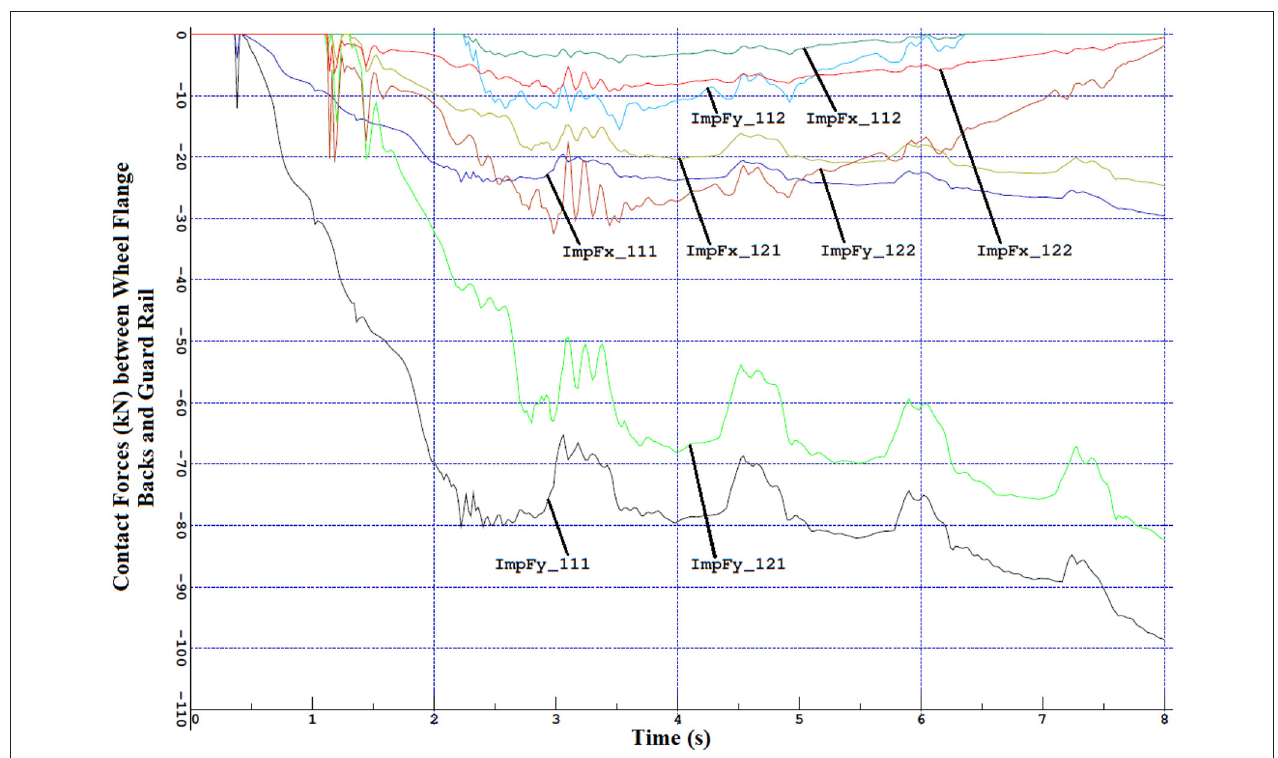
FIGURE 11 | Contact forces between wheel flange backs and guard